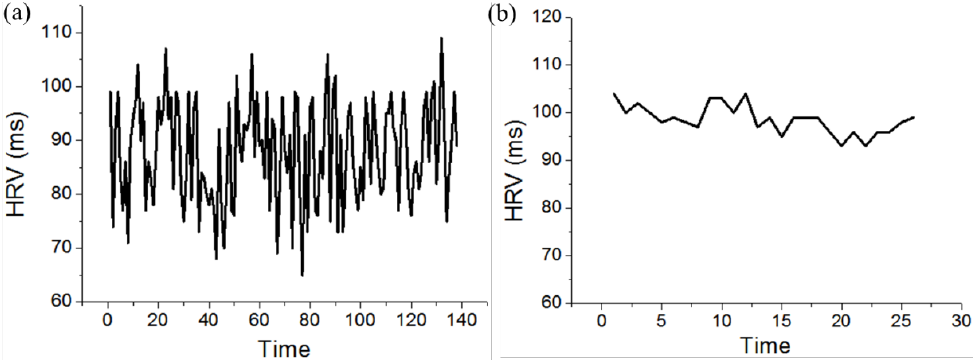
Figure 7. Heart rate variability (HRV) values for activity analysis: ( a ) excited status; ( b ) fatigue status.